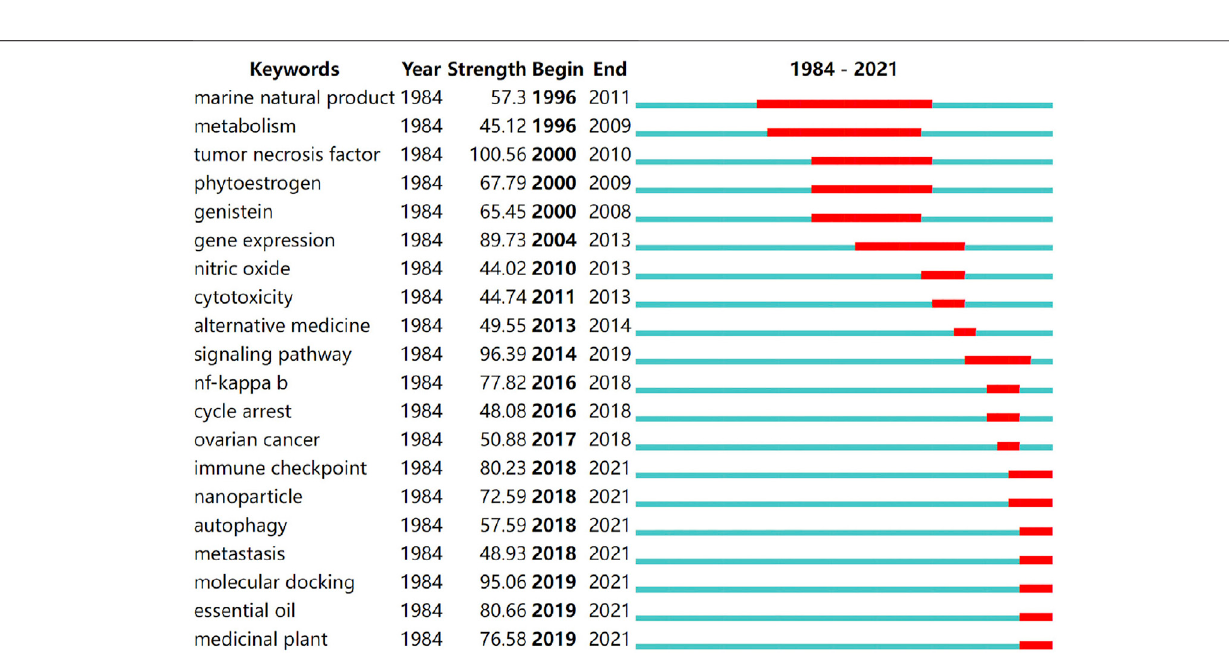
Frontiers in Pharmacology |